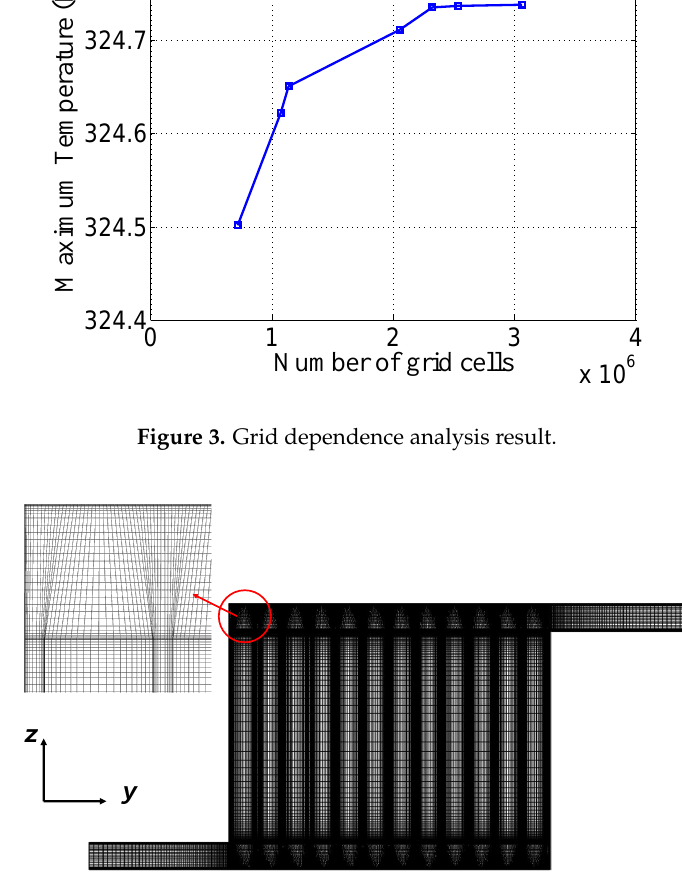
Figure 4. Schematic of the grid system at a certain x